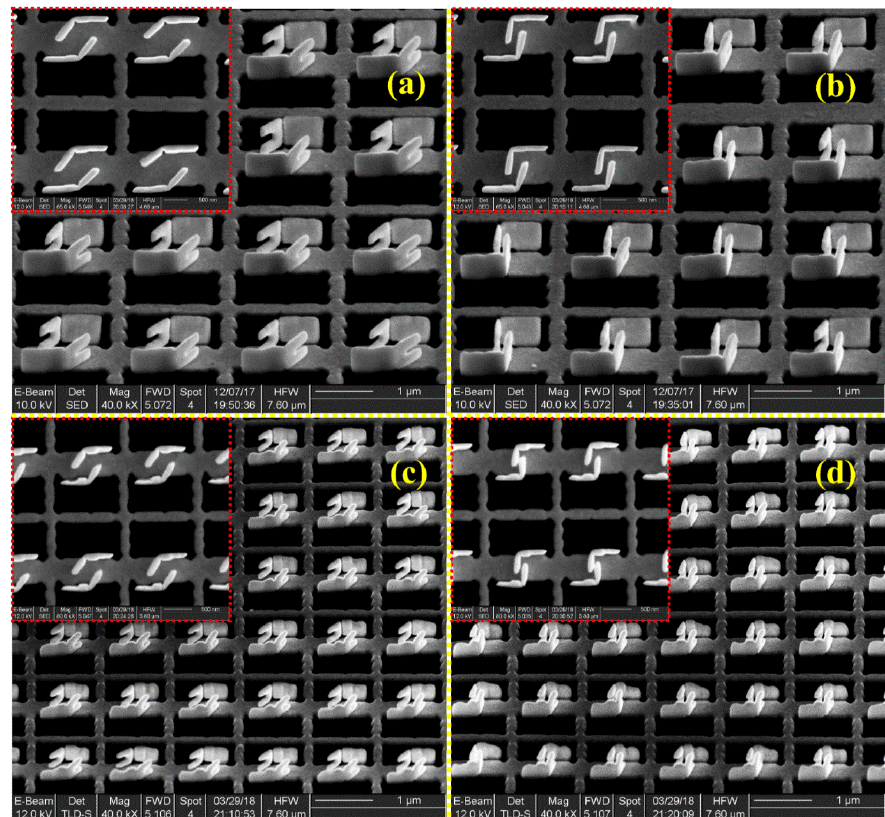
Figure 7. SEM images of the fabricated 3D meta-atom arrays with different cell sizes and claw distances. The inset images are the top view of each 3D meta-atom array, respectively. The overall size is around 60 μm × 90 μm. ( a , b ) are arrays of the same size with a larger claw distance of ~500 nm ( a ) and a smaller distance of ~150 nm ( b ), both with a claw length of ~500 nm. ( c , d ) are arrays of the scaled down size with larger claw distance of ~250 nm ( c ) and smaller distance of ~70 nm ( d ), both with a claw length of ~330 nm. The scale bars are 1 µ